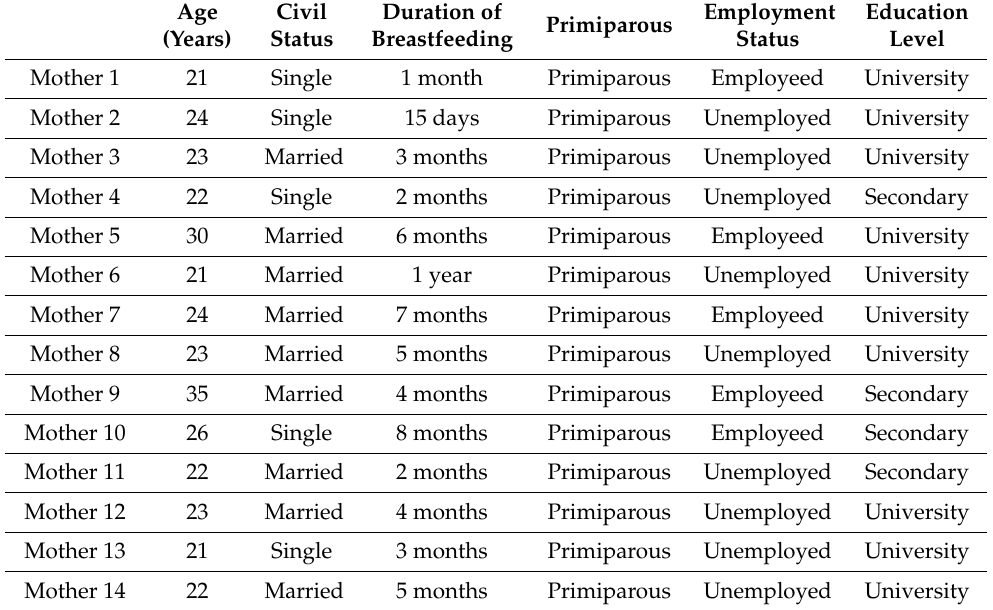
Table 1. Participant characteristics.